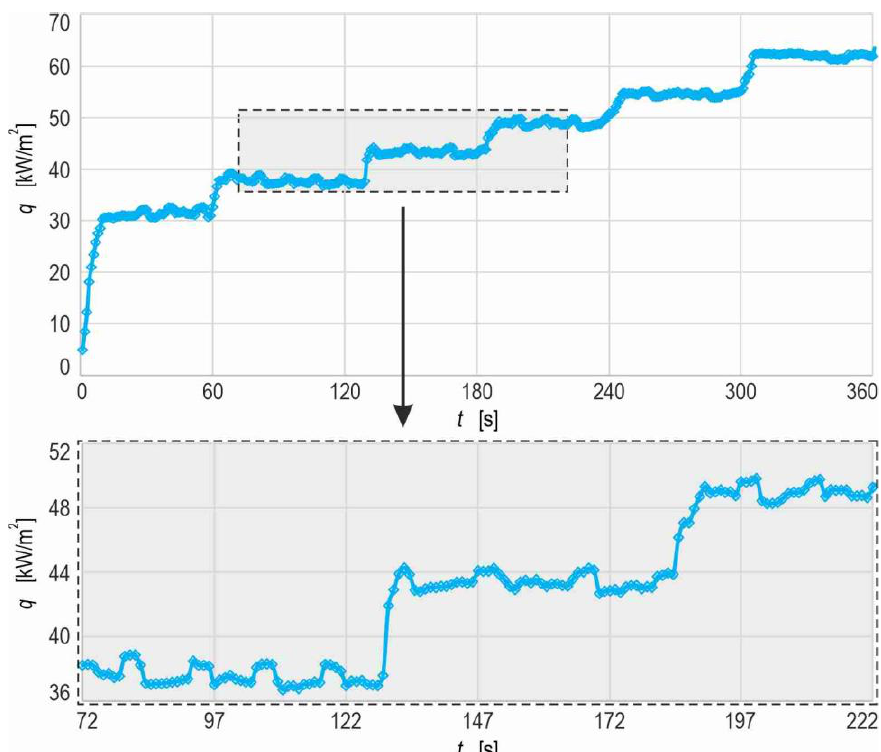
Figure 7. Heat flux supplied to the heated foil as a function of time; the data referring to the subcooled boiling region is marked in grey; the experimental parameters are shown in Table 1.